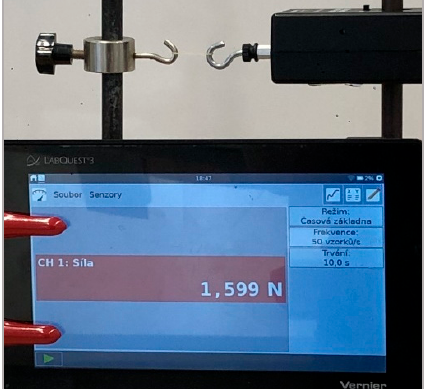
Figure 1. Elastic stretched to the exact distance on the force meter “ScienceCube” connected to the portable data logger “LabQuest3”.